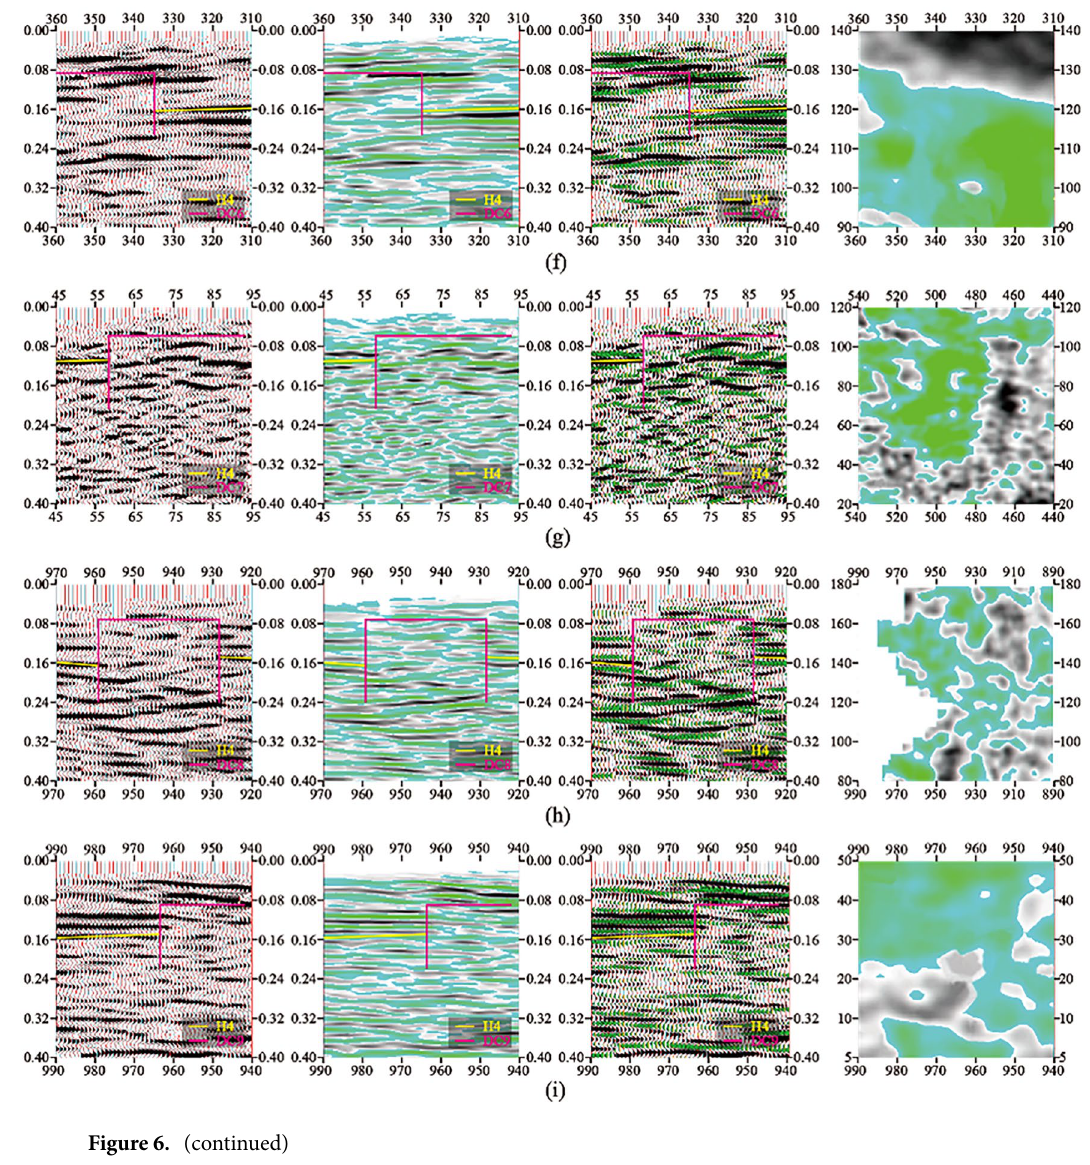
Fig. 9. The results of high-density electrical prospecting, 3D seismic prospecting and transient electromagnetic prospecting can well verify and complement each other. Geological drilling exploration